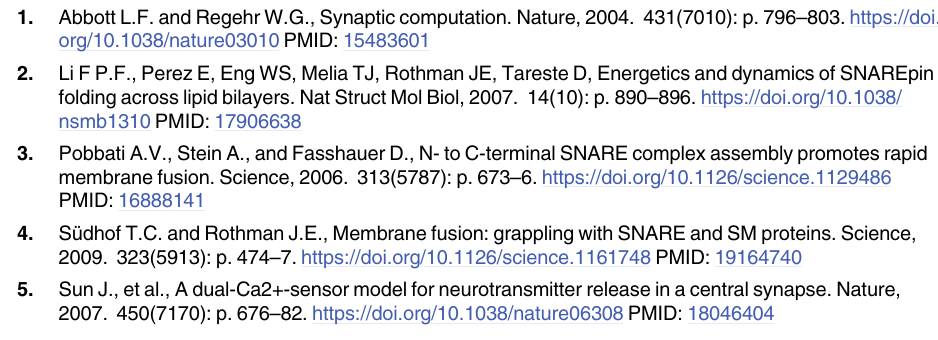
dotted lines follow relative release fidelity for probe spikes. Fig K. Saturation of Facilitation Parameters. (A) Facilitation parameter f( � ) increases almost linearly from one spike (f(n-1)) to the next (f(n)), until it approaches some limit N � 1. (B) Curves represent the unseen change in f( � ) between spikes. Dots represent actual values observed at spike times, values determined by the Ca 2+ -triggered increment in release fidelity at each spike. Steady-state value for facilitation parameter limited by stimulus frequency and by value of N. No facilitation above baseline occurs for N = 1. Fig L. Release Rate Parameters and Facilitation Metaparameters Fitted to Empirical Histogram Profiles. Errors across all cases in linear and logarithmic space for the predictive